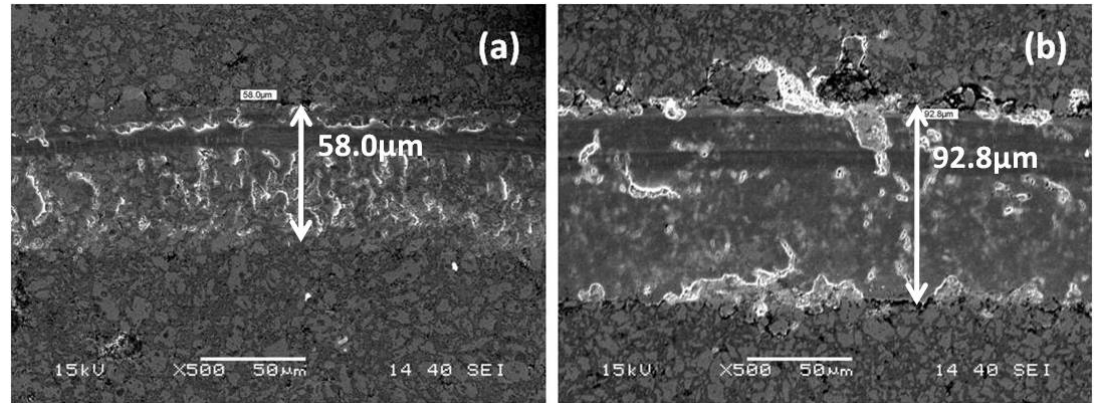
Fig. 9 SEM micrographs of wear tracks (a) nano-TiO2 dispersed alloy C (b) nano-Y2O3 dispersed alloy B.